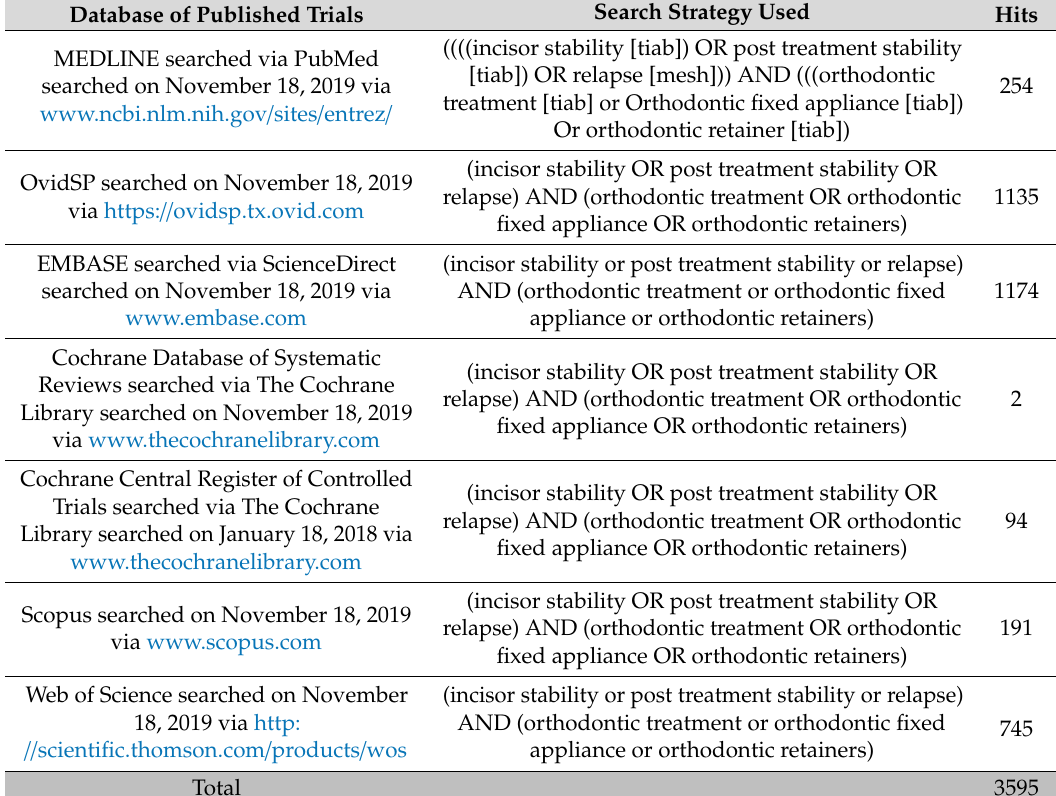
Table 1. Performed electronic